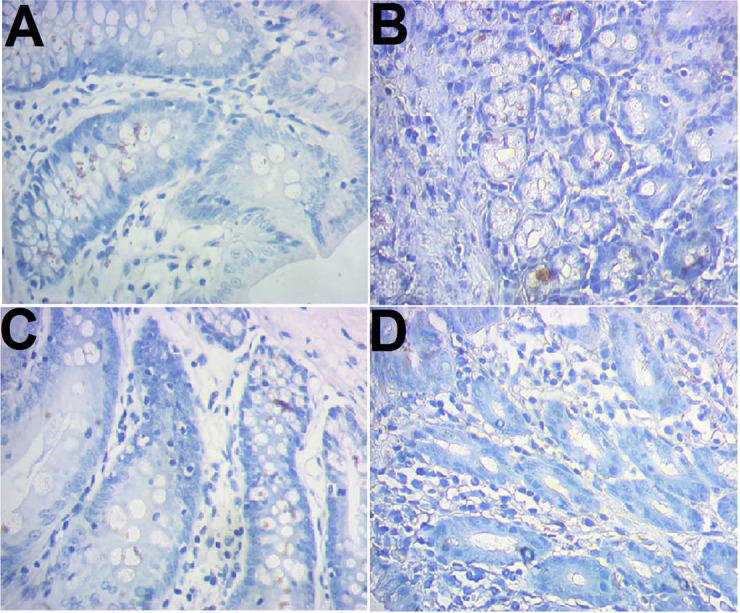
Immunohistochemical staining of CD103+ ileocecal DC cells.(A) Control (normal rat); (B), model control (rat models injected with saline solution); (C), RNAi control (rat models injected with empty vector); (D) RNAi model (rat models injected RNAi-PDIA). Ileocecal tissues were isolated after modelling, fixed in 10% neutral formalin and sectioned. The slides were incubated with CD103 antibody and examined after color development. Brown-colored cells were rated as positive for CD103.